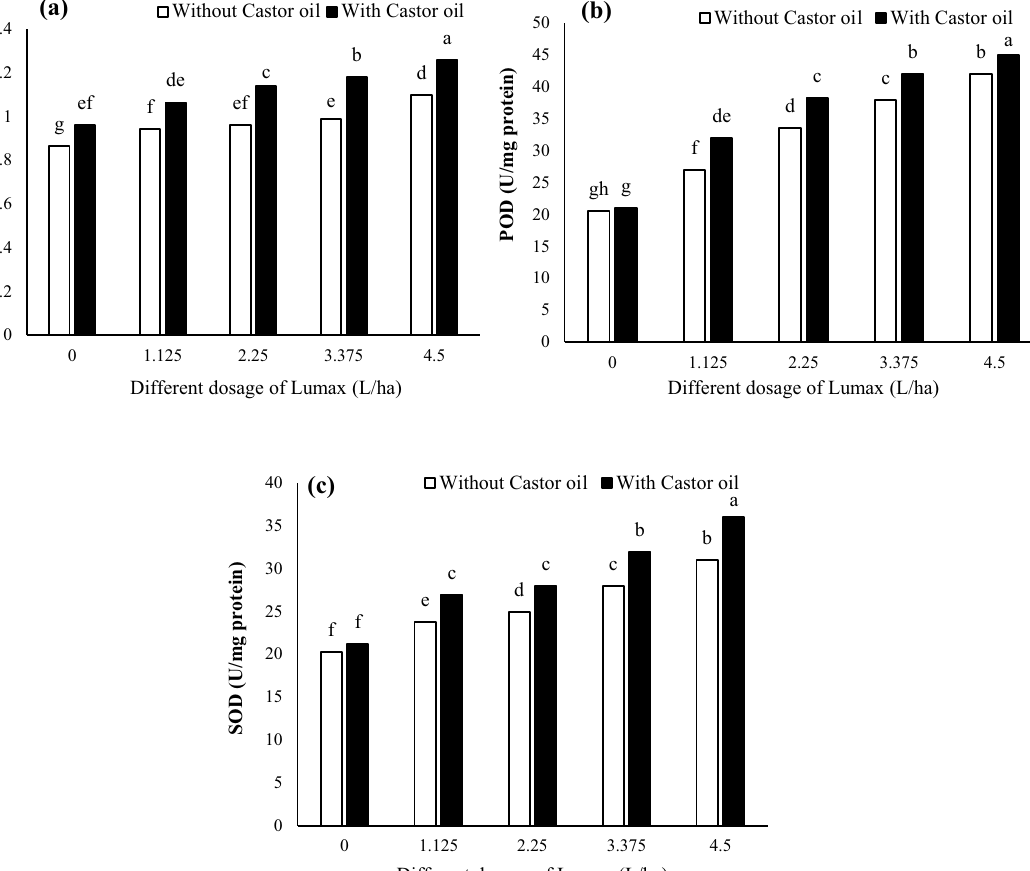
Figure 2. Changes in ( a ) CAT, ( b ) POD, and ( c ) SOD activity of Solanum nigrum in response to different doses of Mesotrion + S-metolacholor + Terbuthylazine with and without Castor oil. Each value is the mean of four replicates. Different letters represent significant differences ( P < 0.01).